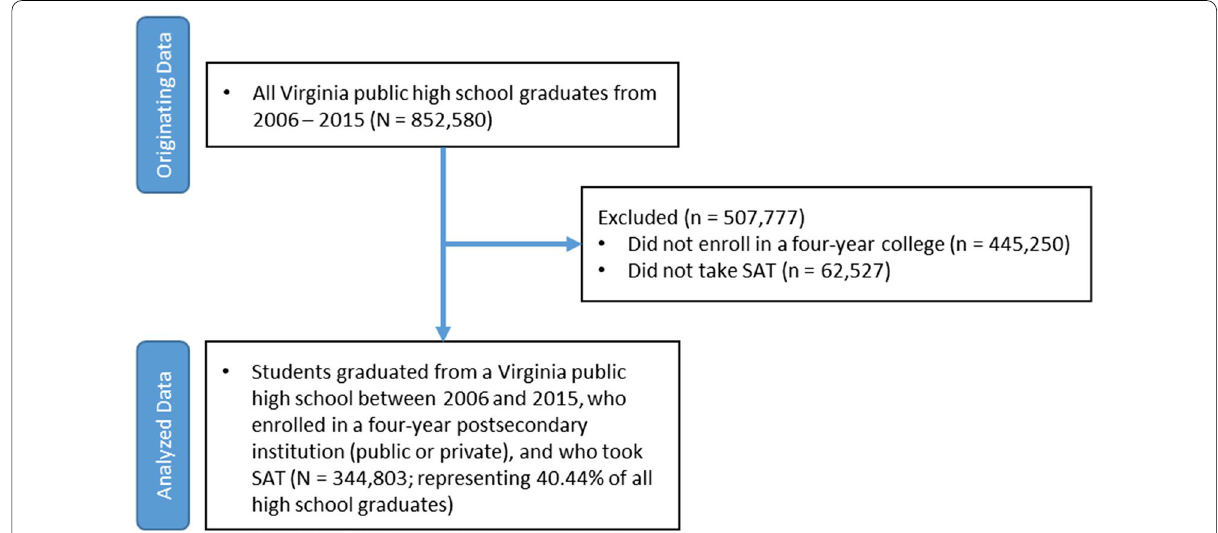
Fig. 1 Flow diagram for analyzed